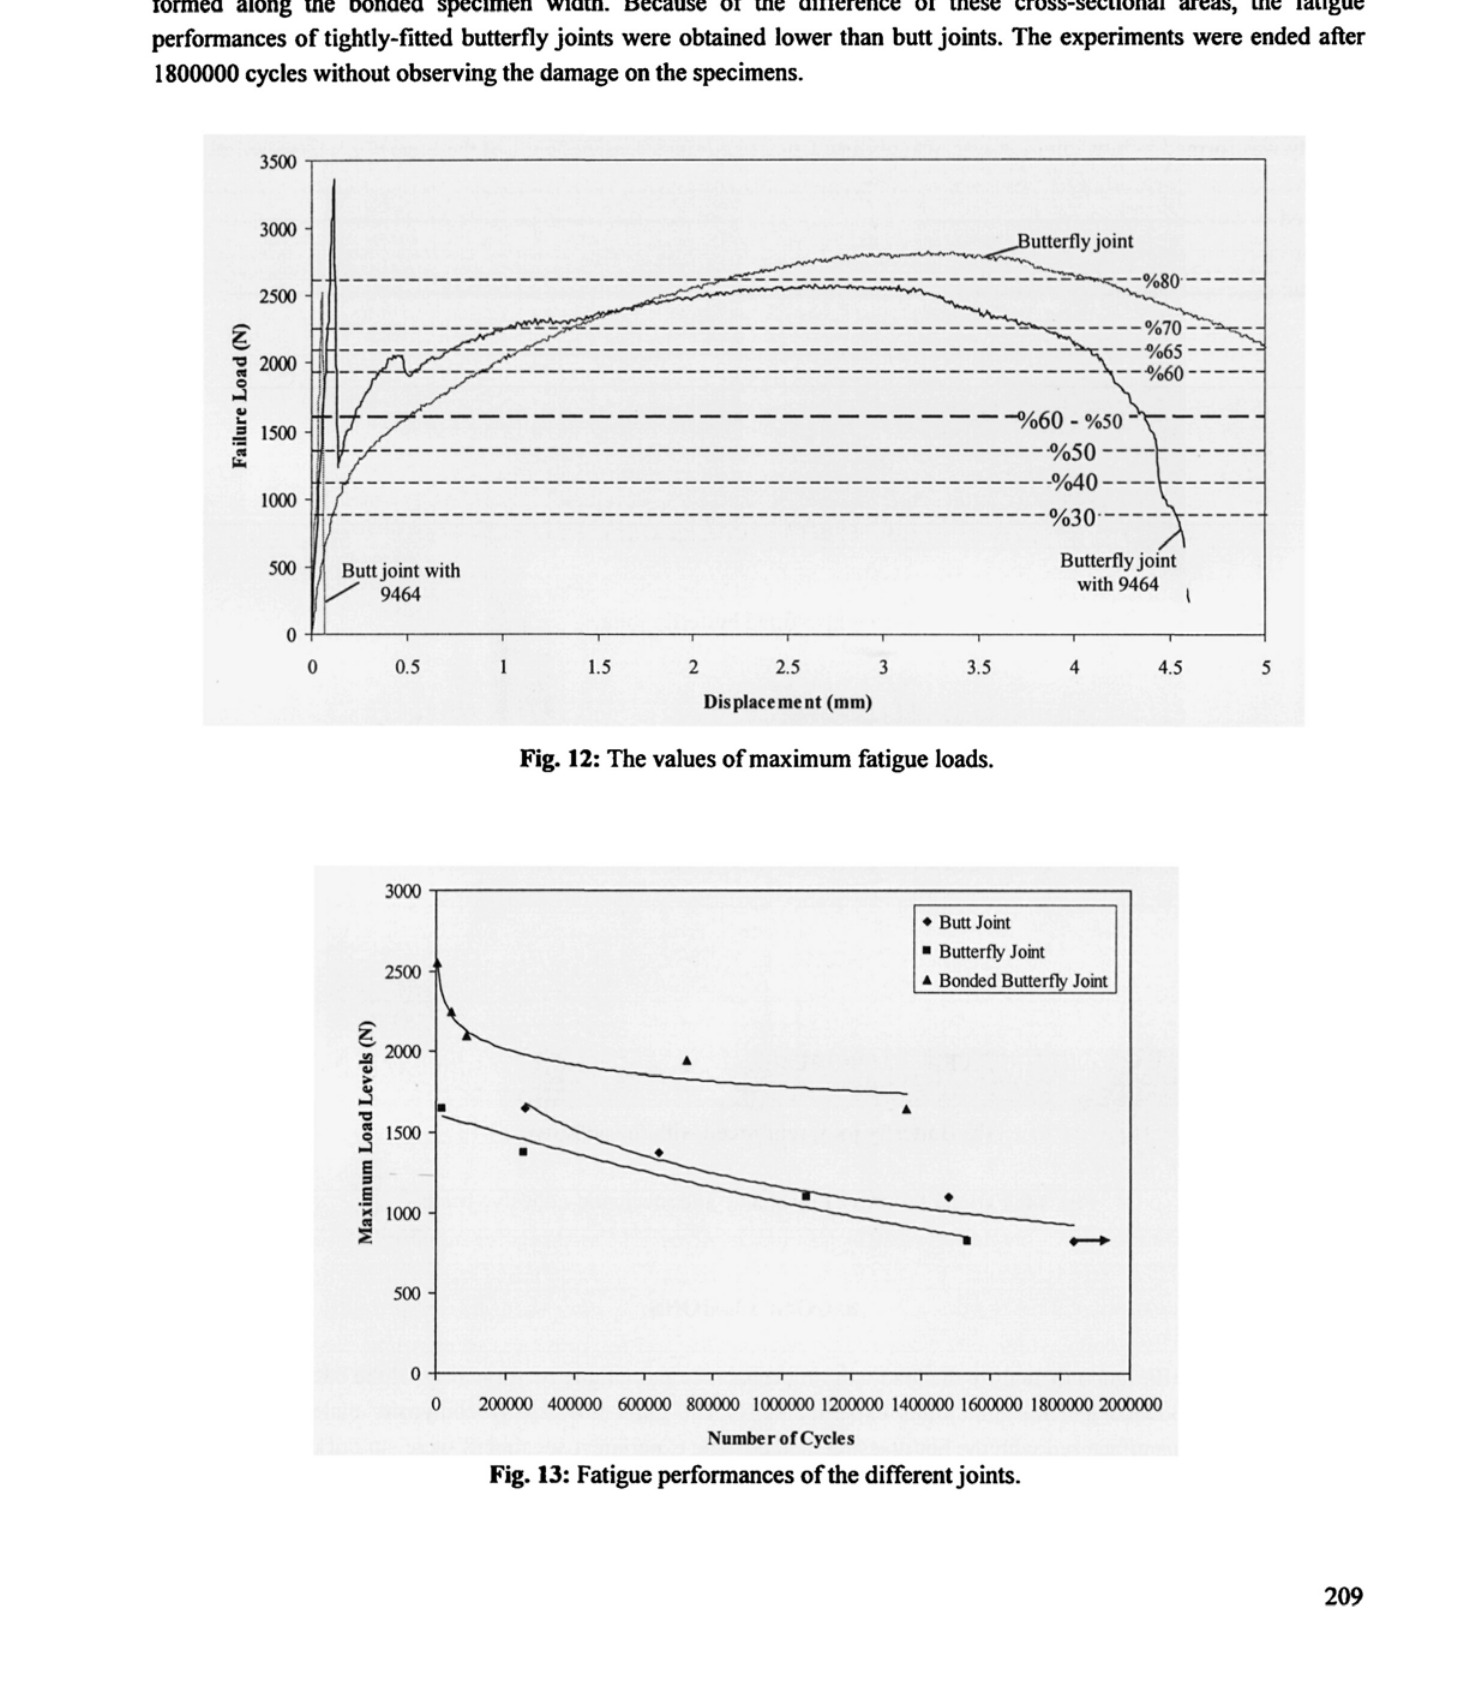
Fig. 12: The values of maximum fatigue loads.